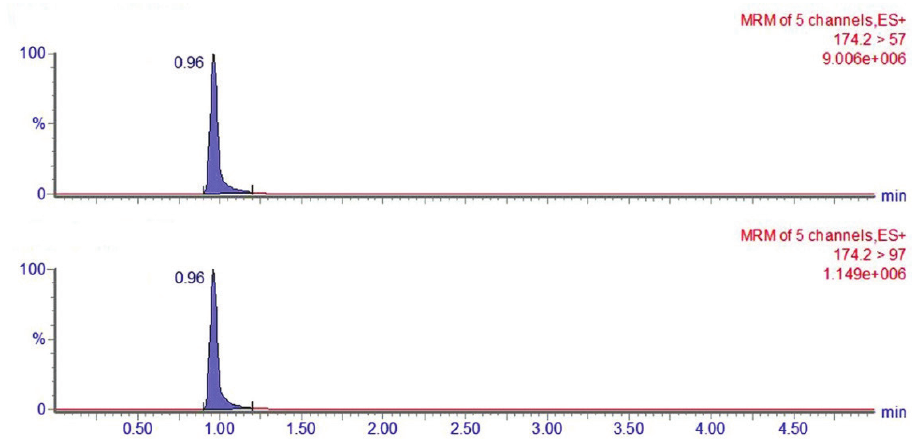
Figure 4. MRM chromatograms of muscarine from Pseudosperma arenarium